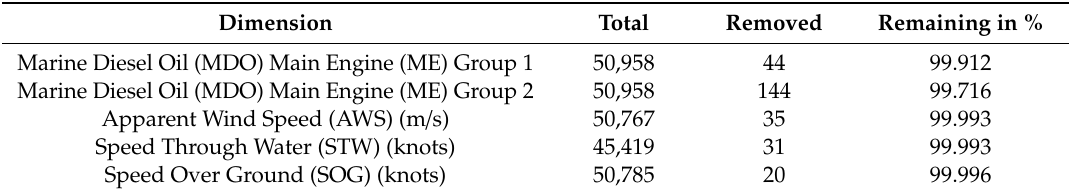
Table 2. Amount of remaining data points per series after cut-off at 47%.